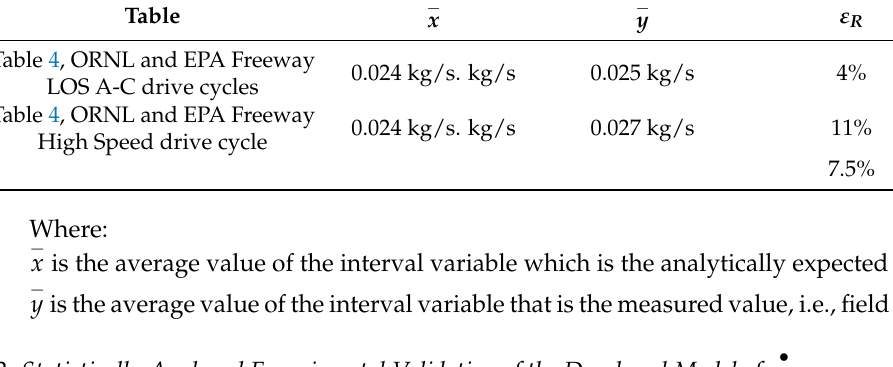
Table 5. Summary of the statistical analysis on Table − x Table 4, ORNL and EPA Freeway Table 4, ORNL and EPA Freeway